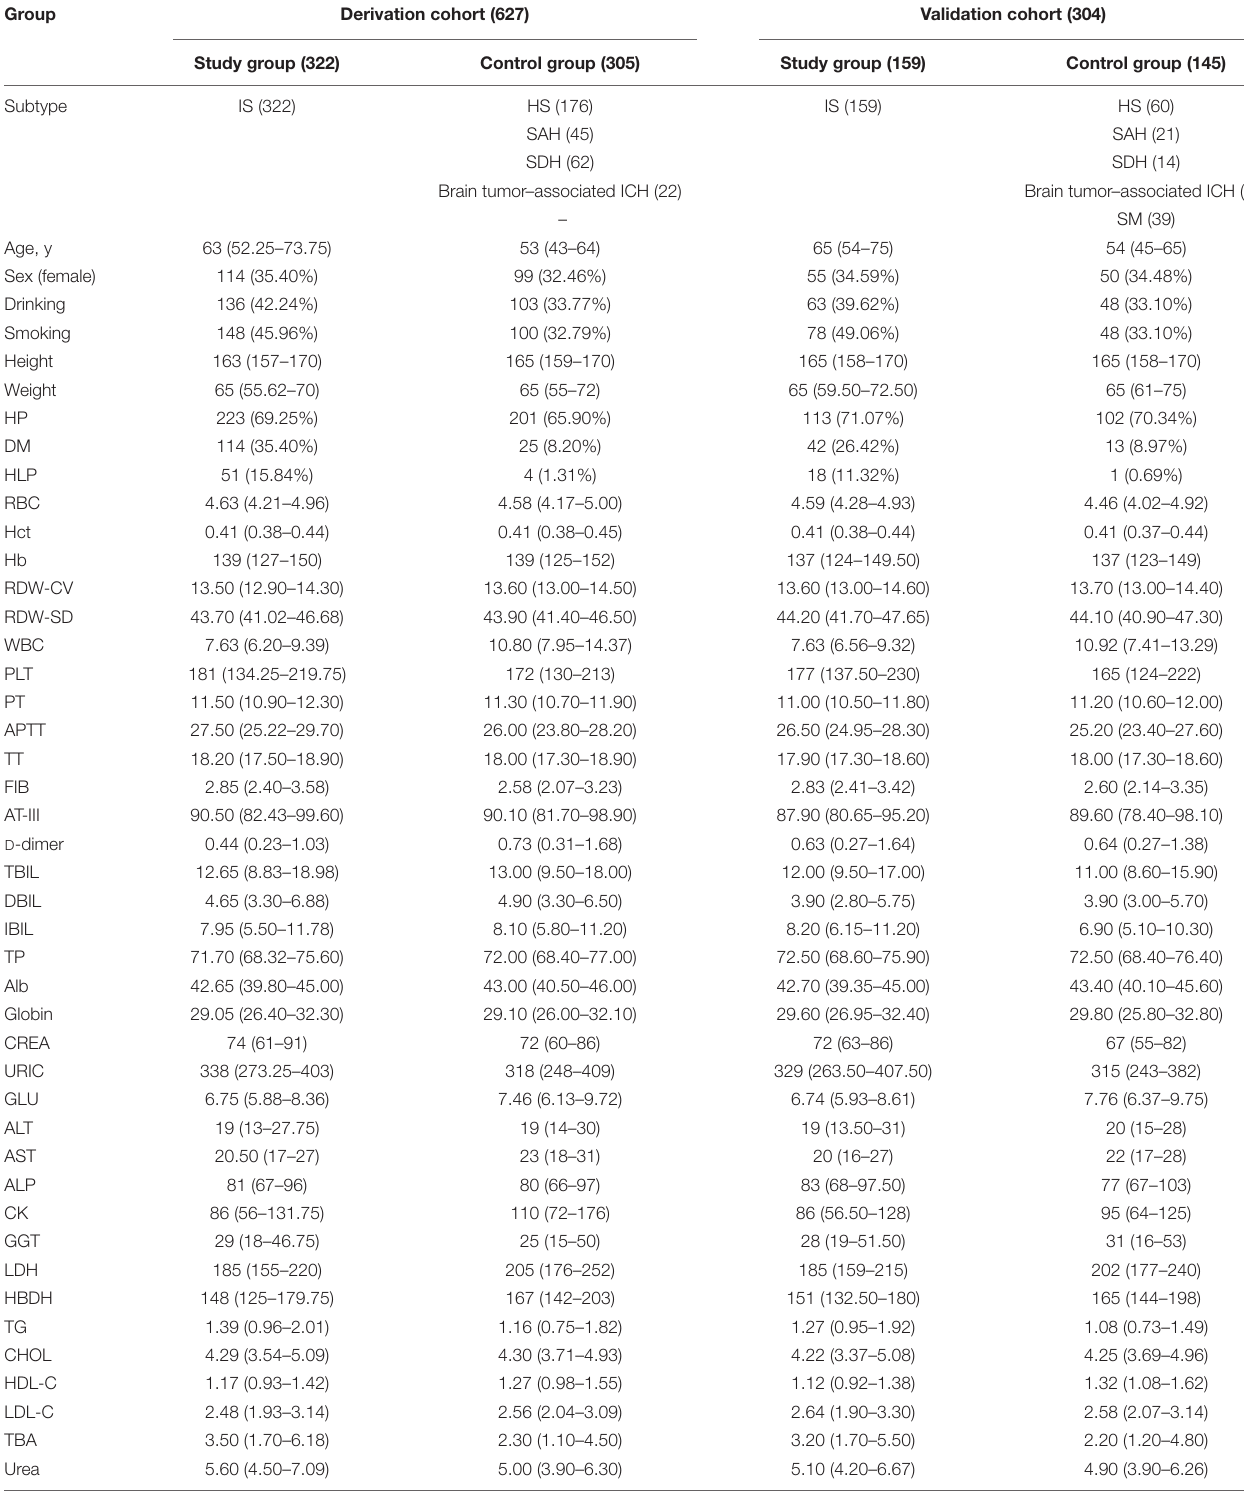
TABLE 1 | Baseline patient